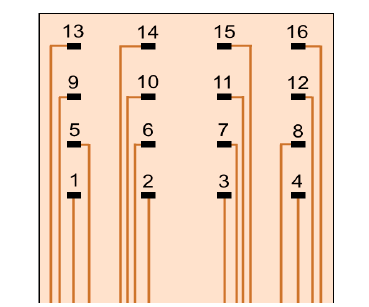
Figure 3. Hall effect sensor board used for horizontal special accuracy testing and vertical calibration of magnet when positioned directly above sensor.